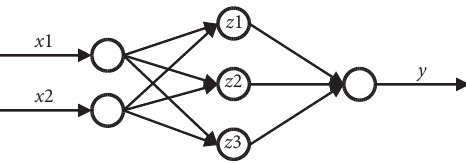
Figure 6: Structure of network under Maxout.